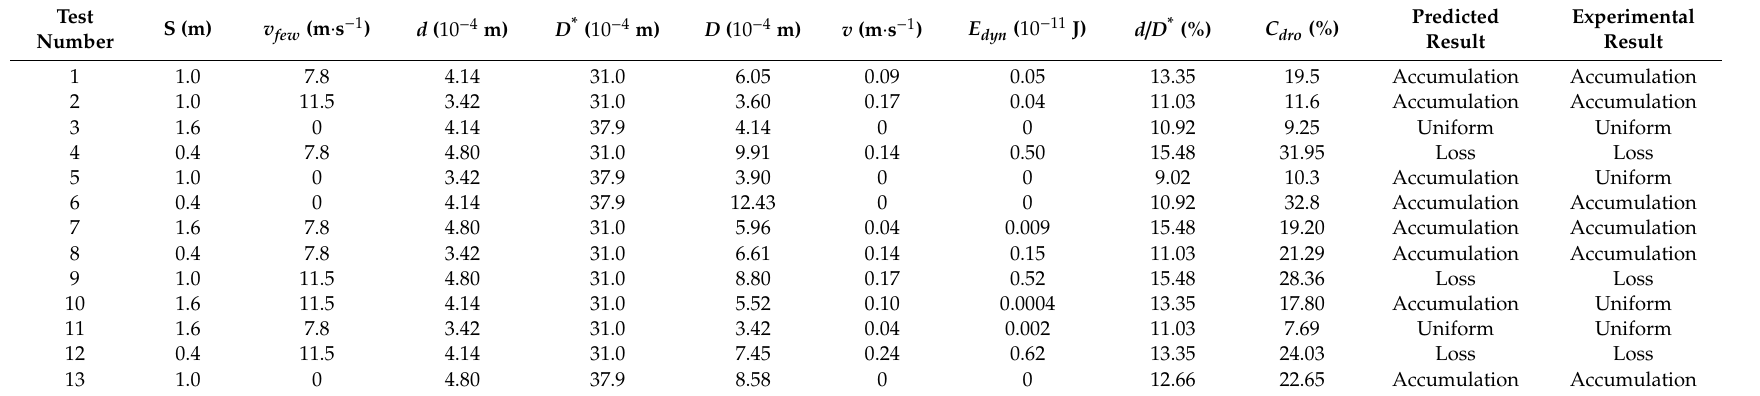
Table 4. Predicted and actual states of deposition of droplets on the reverse of Citrus leaves under di ff erent combinations of operating